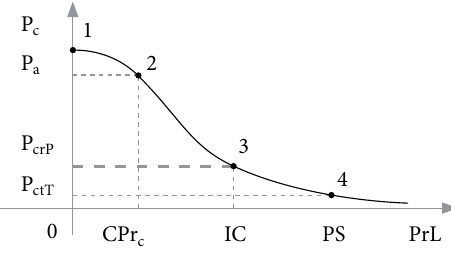
Fig. 1. Distribution curve for probability of occurrence of definite profit